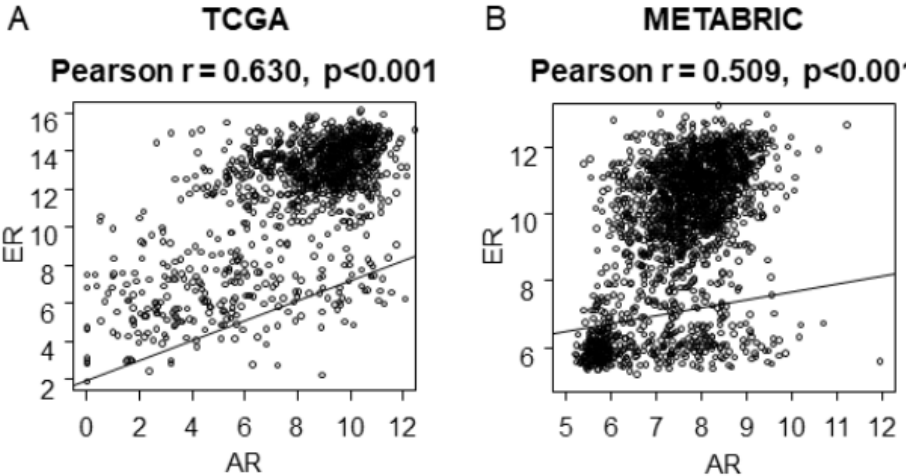
Figure 2. Pearson correlation coefficient (r) and p -value (p) between AR mRNA expression and ER mRNA expression. ( A ) A scatter plot of TCGA cohort; ( B ) A scatter plot of METABRIC cohort.